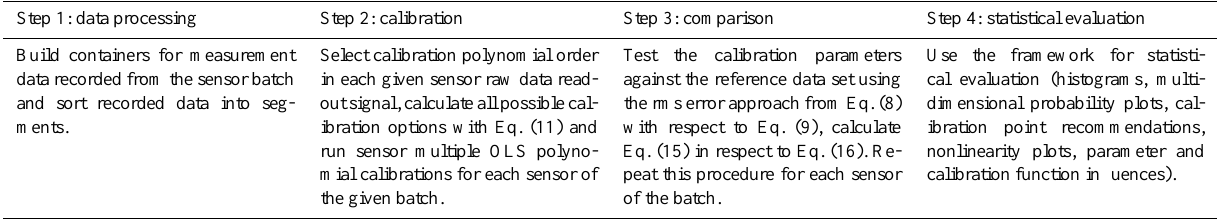
Table 1. A typical calibration workflow using the proposed framework; data processing, calibration and evaluation are implemented in independent